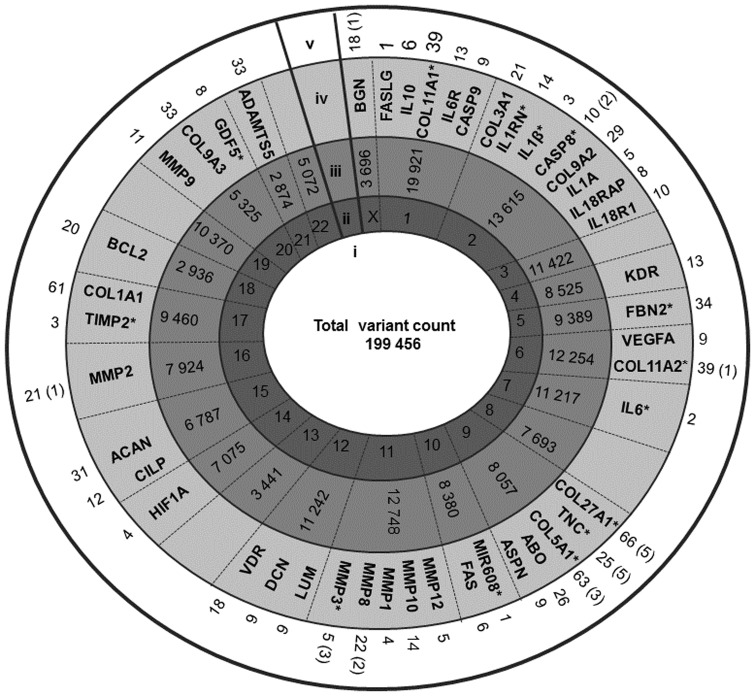
Distribution of variants identified by whole exome sequencing within genes previously associated with the risk of musculoskeletal soft tissue injuries.Schematic diagram demonstrating the number and distribution of variants identified through whole exome sequencing of ten exemplar controls and ten exemplar cases. (i) Total number of variants identified across the 20 sequenced exomes. (ii) The autosomes numbered from 1–22, and the X gonosome. The Y gonosome is not presented due to its size relative to the other chromosomes. A total of 32 variants were called on the Y chromosome. (iii) Total number of variants identified mapping to each chromosome using WES. (iv) Genes previously associated with risk of Achilles tendinopathy and other musculoskeletal soft tissue injuries mapping to the respective chromosomes. (*) Asterix indicates genes specifically associated with Achilles tendinopathy. (v) Total number of variants identified mapping to the respective genes with number of variants that meet the allele frequency difference threshold in parentheses.